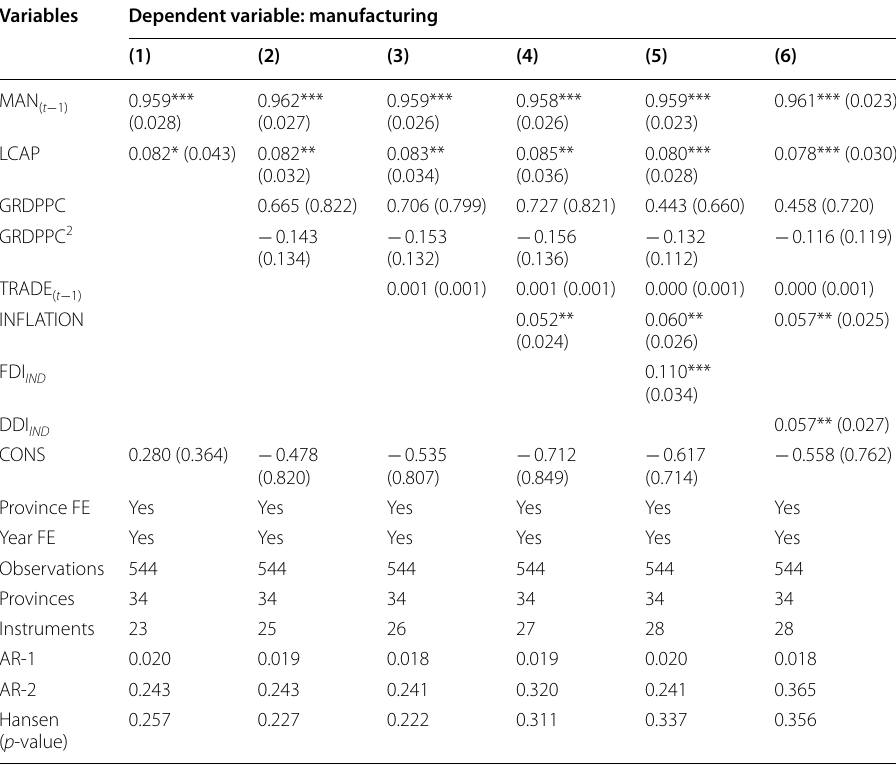
Table 2 Local capital spending and industrial development: main